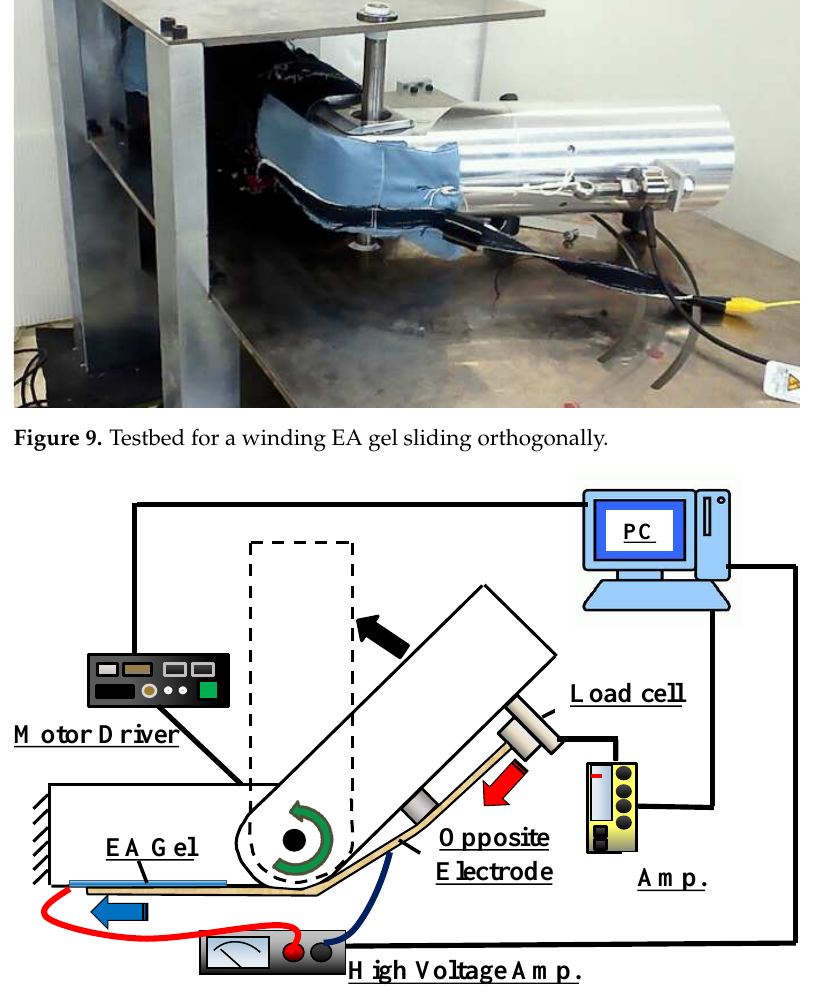
Figure 10. Schematic of the apparatus in Figure